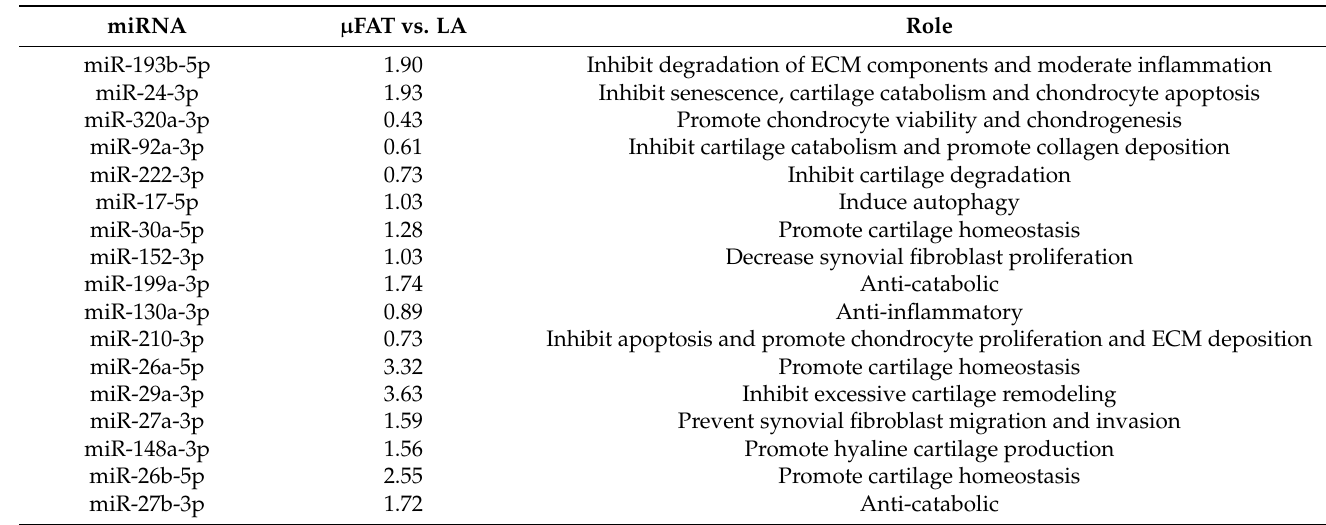
Table 1. Chondroprotective miRNAs in LA-EVs and µ FAT-EVs first quartile. miRNA µ FAT vs. LA